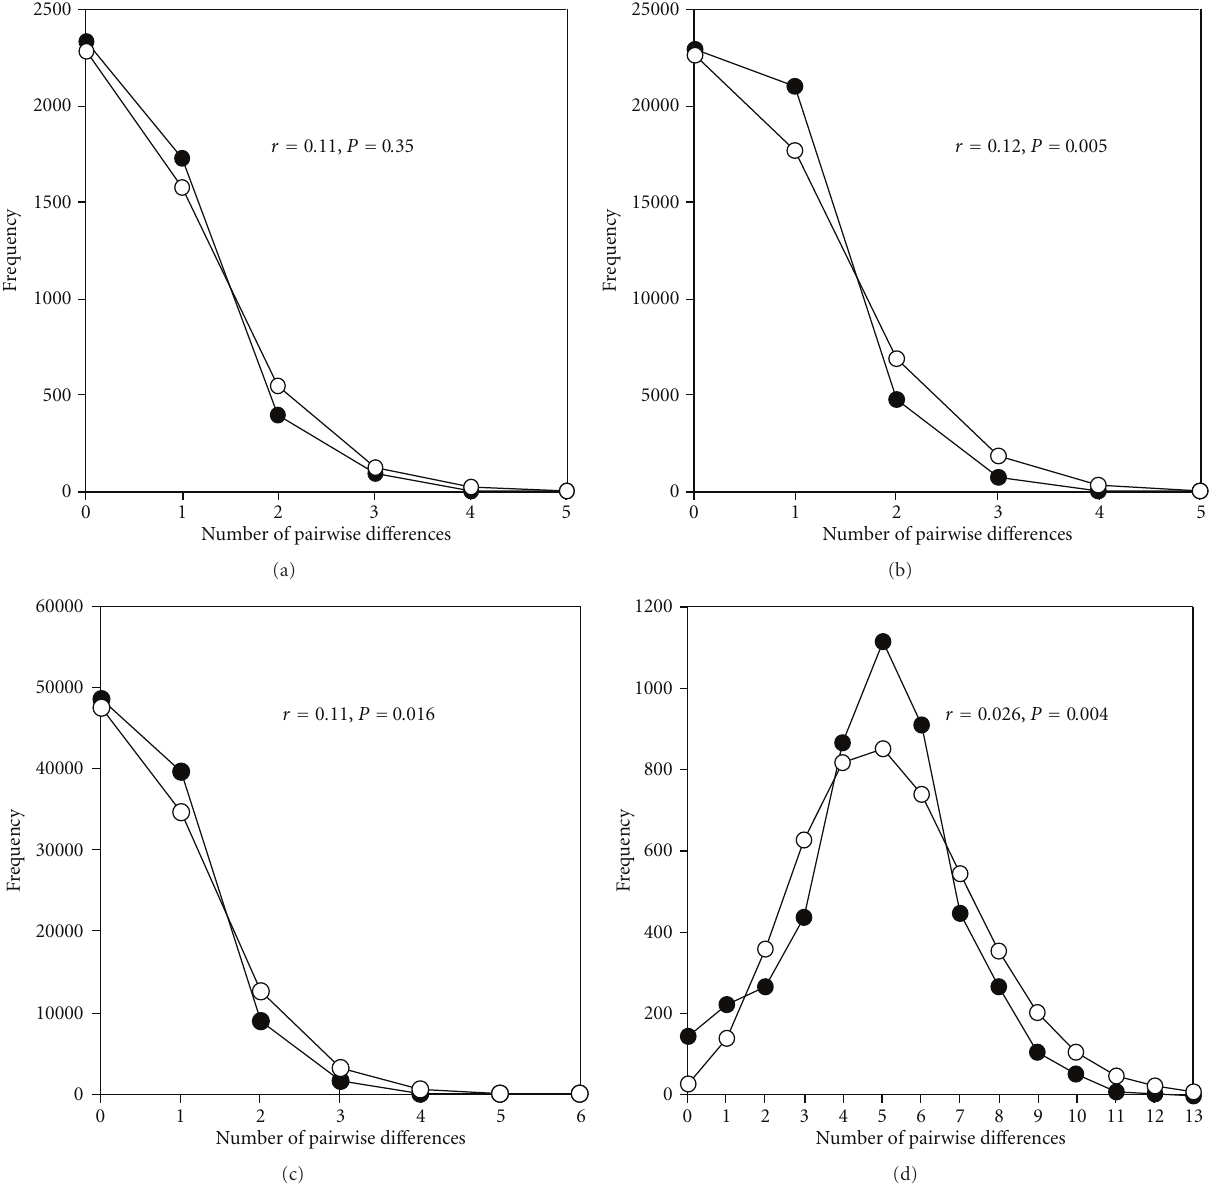
Figure 3: Mismatch distributions of mitochondrial cyt b sequence data from Acanthurus nigroris from (a) all Main Hawaiian Island (MHI) populations ( N = 92 individuals), (b) all Northwest Hawaiian Island (NWHI) populations ( N = 315 individuals), (c) the entire Hawaiian archipelago (including Johnston Atoll, N = 441 individuals), and (d) all remaining Pacific populations ( N = 98 individuals). Observed and simulated pairwise di ff erences calculated in ARLEQUIN vers. 3.1 are represented by lines drawn through black and open circles, respectively. Harpending’s raggedness index ( r ) and associated P values are shown for each